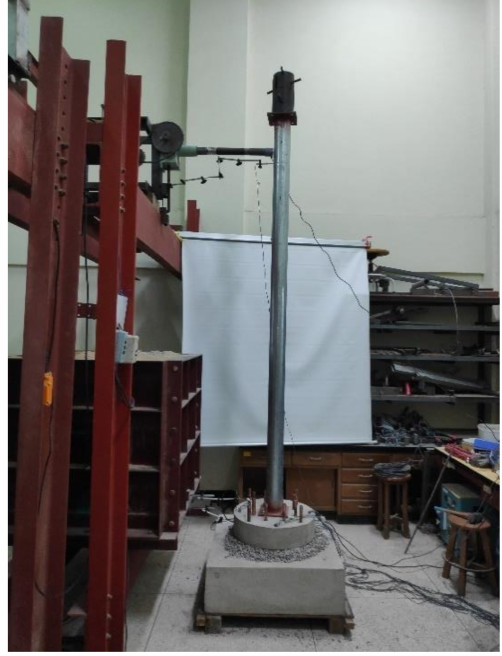
Figure 10. Increased self-weight experiment for